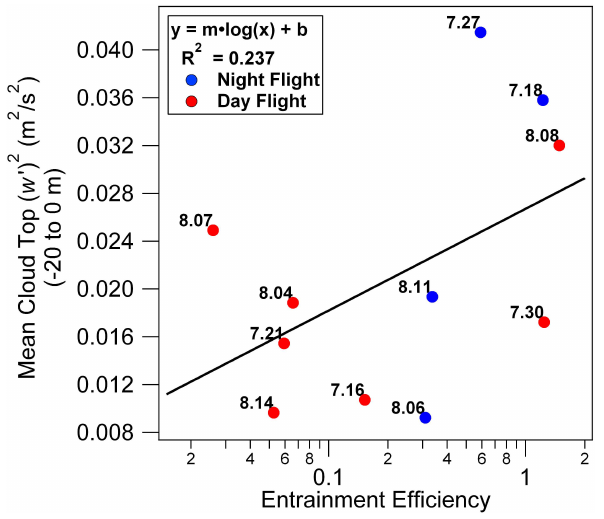
Fig. 13. Scatter plot of the entrainment efficiency η versus the ver- tical component of TKE (cid:0) w 0 (cid:1) 2 near cloud top (from z s = 0m to − 20 m). Each point is the average value for the flight, with the cor- responding date beside each point, and color denoting day and night flights.